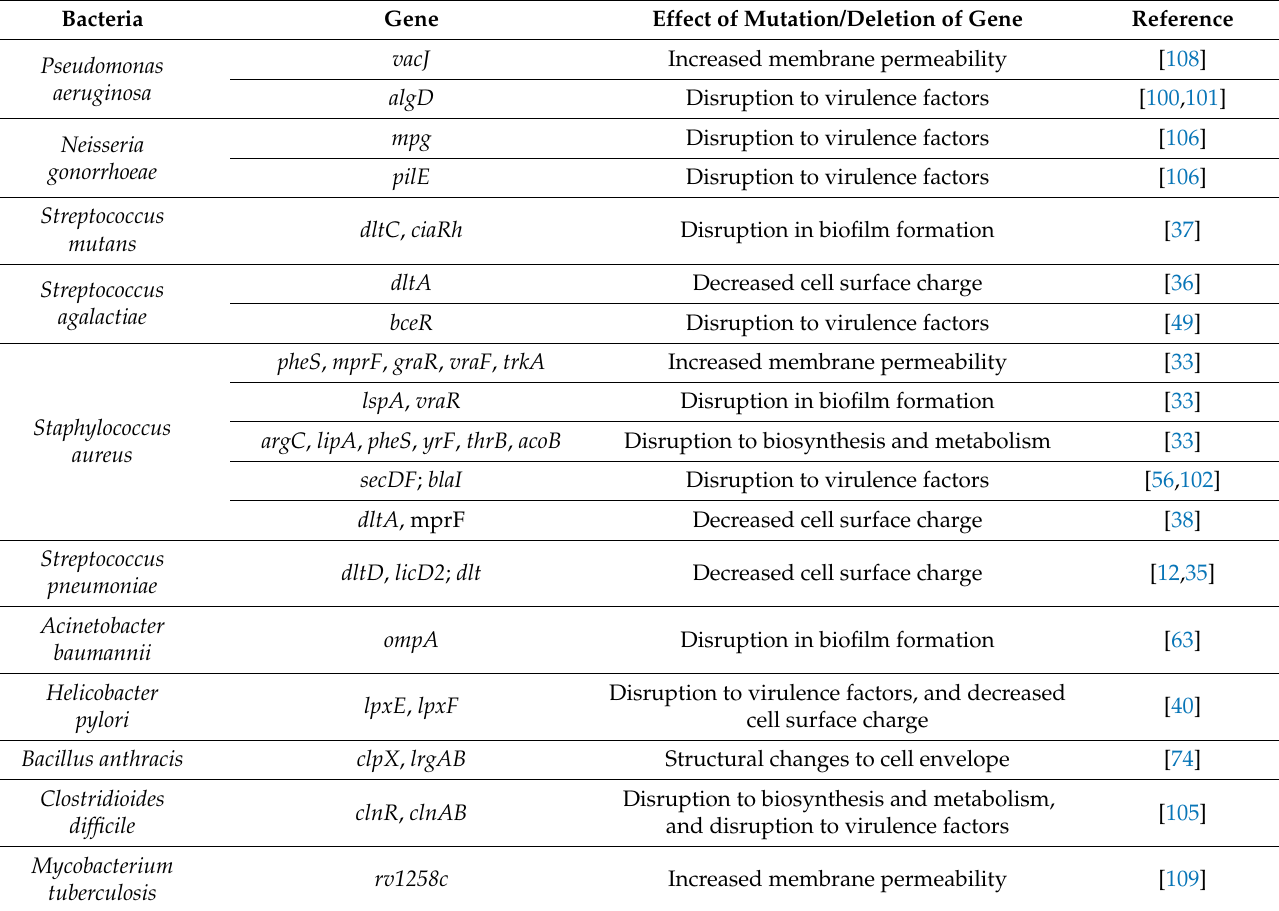
Table 1. Mutations or deletions in genes that result in an increased susceptibility to LL-37 killing. Bacteria Gene Effect of Mutation/Deletion of